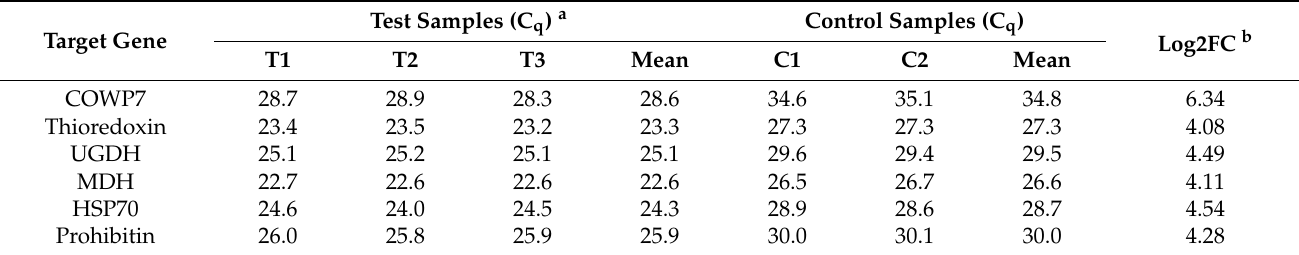
Table 3. Comparative quantitative analysis of selected target genes using 18S rRNA as the reference gene (normalizer). Target Gene